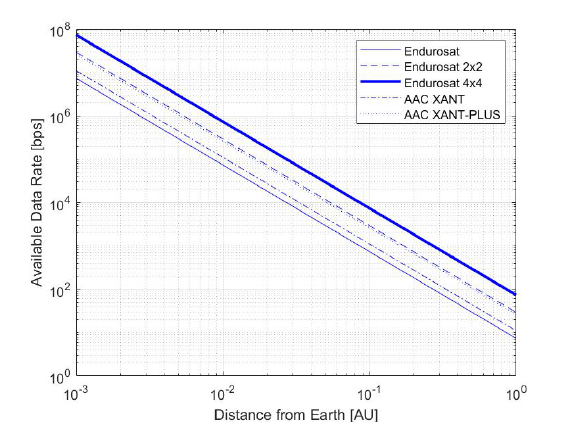
Figure 7. Off-the-shelf X-band antennas data-rate in function of typical NEA fly-by distance from the Earth (assuming 2W of Radio-Frequency (RF) transmitting